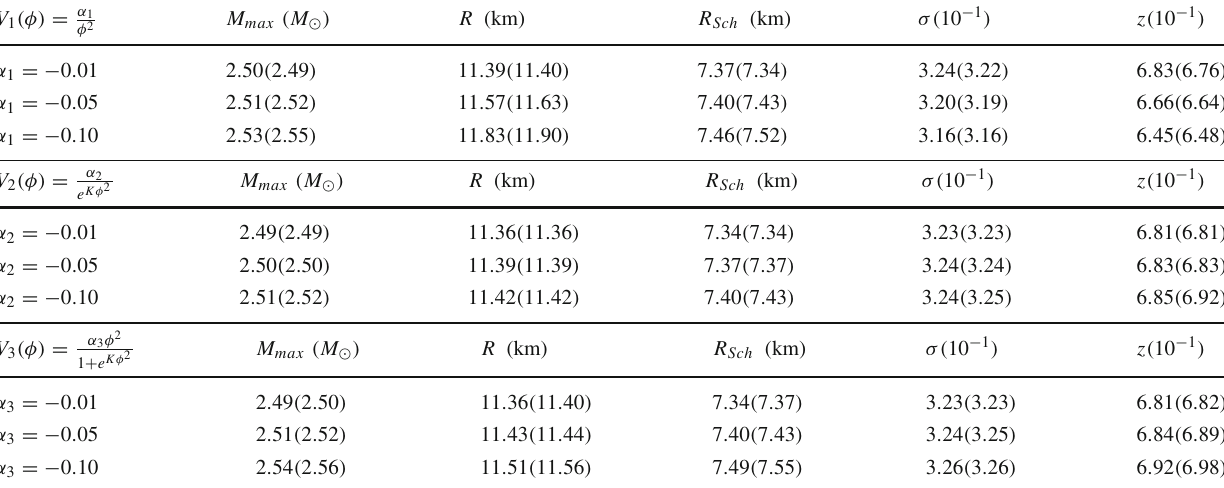
Table 6 Structure properties of neutron star in mimetic gravity for MPA1 EoS with φ( 0 ) = 1 ( φ( 0 ) = 0 . 8) and K = 0 . 5